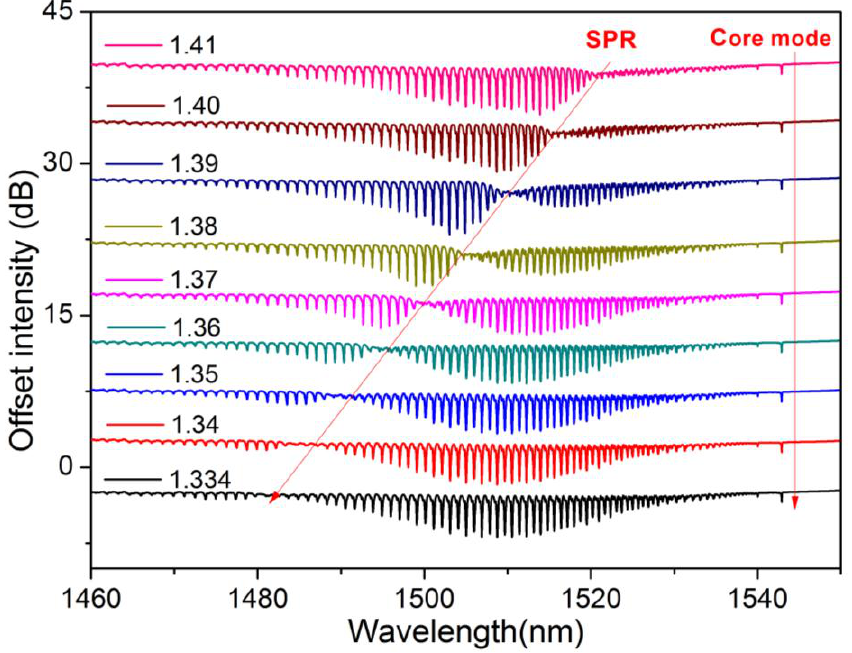
Figure 10. Evolution of the SPR mode in the transmitted amplitude spectrum of a gold-coated 10° TFBG as a function of a change of the surrounding refractive index.